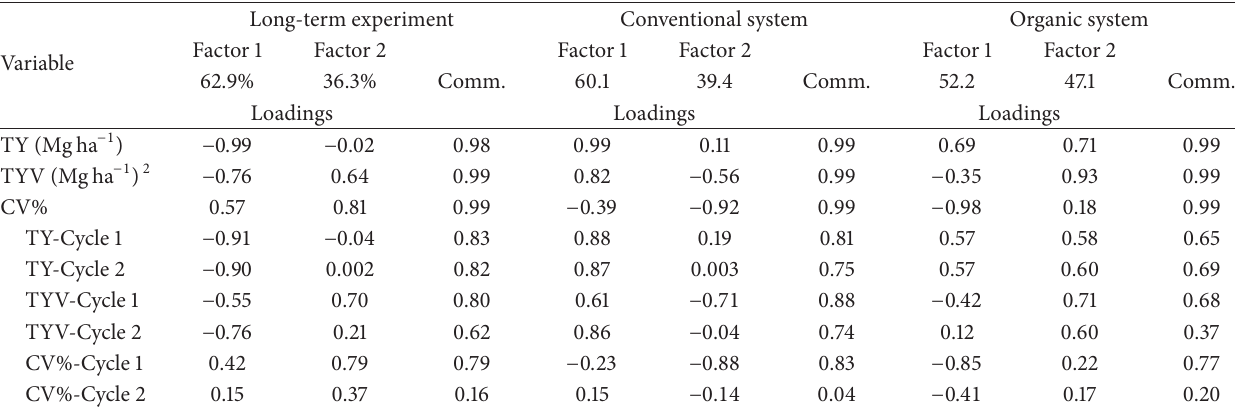
Table 5: Basic statistics of principal components analyses using three main variables (TY, TYV, and CV%) and six supplementary variables representing Cycle 1 and Cycle 2 of each variable in a long-term field experiment and in each of the conventional and organic cropping systems.